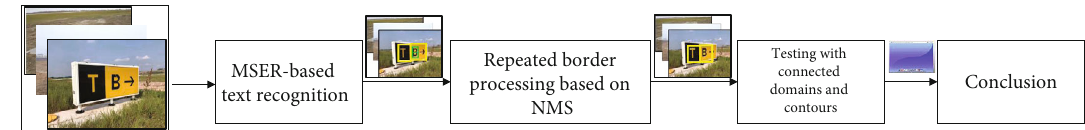
Figure 7: The fl owchart of the improved fusion algorithm.